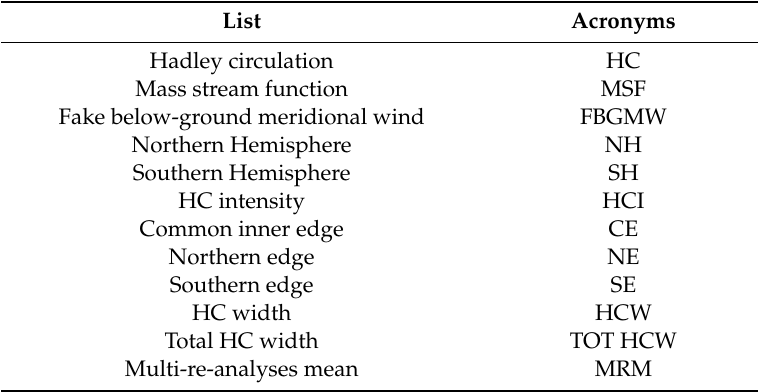
Table 1. List of the acronyms used in this study.